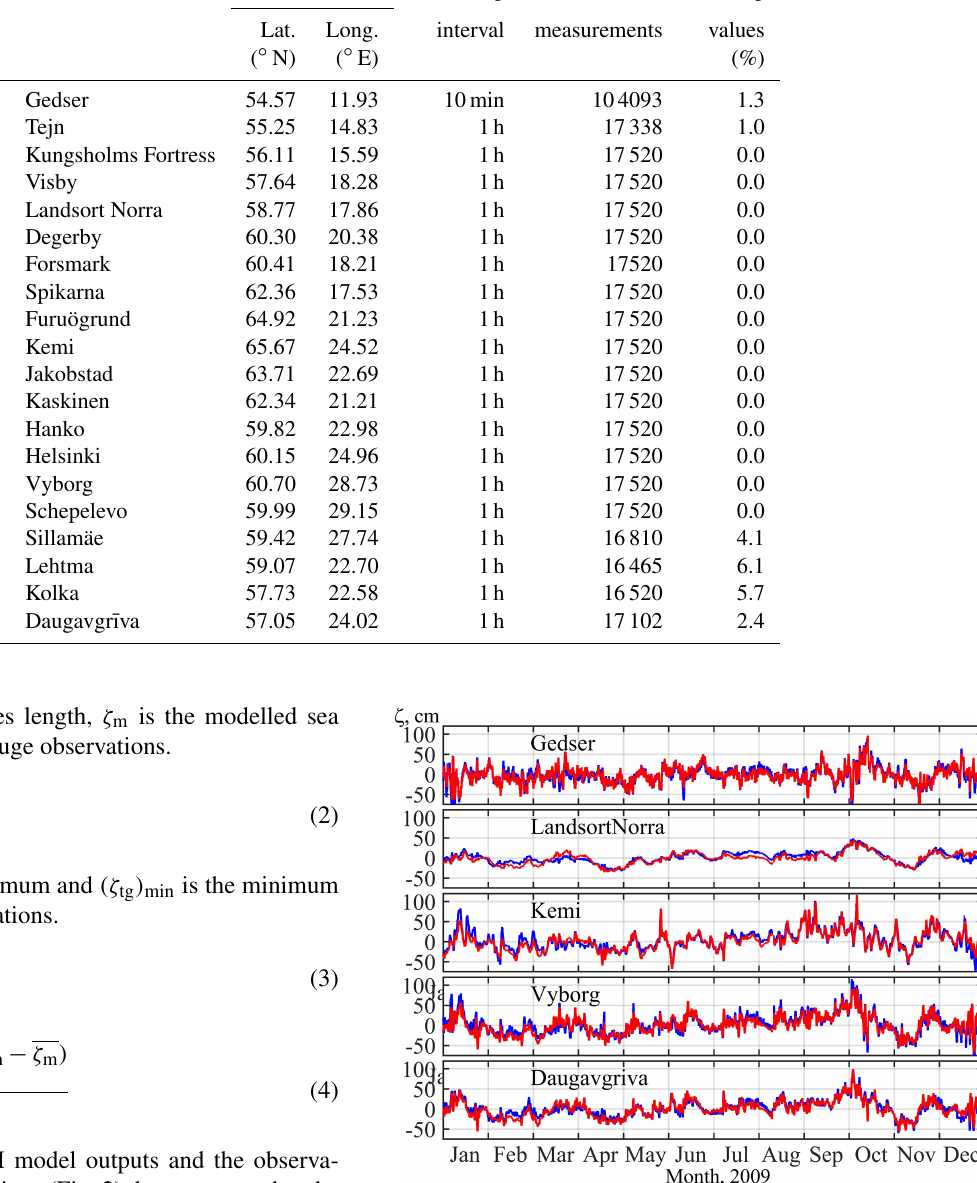
Table 1. Tide gauge stations used in the study (state for study period 2009–2010). No. Station name Coordinates Measuring Number of Missing Lat. Long. interval measurements